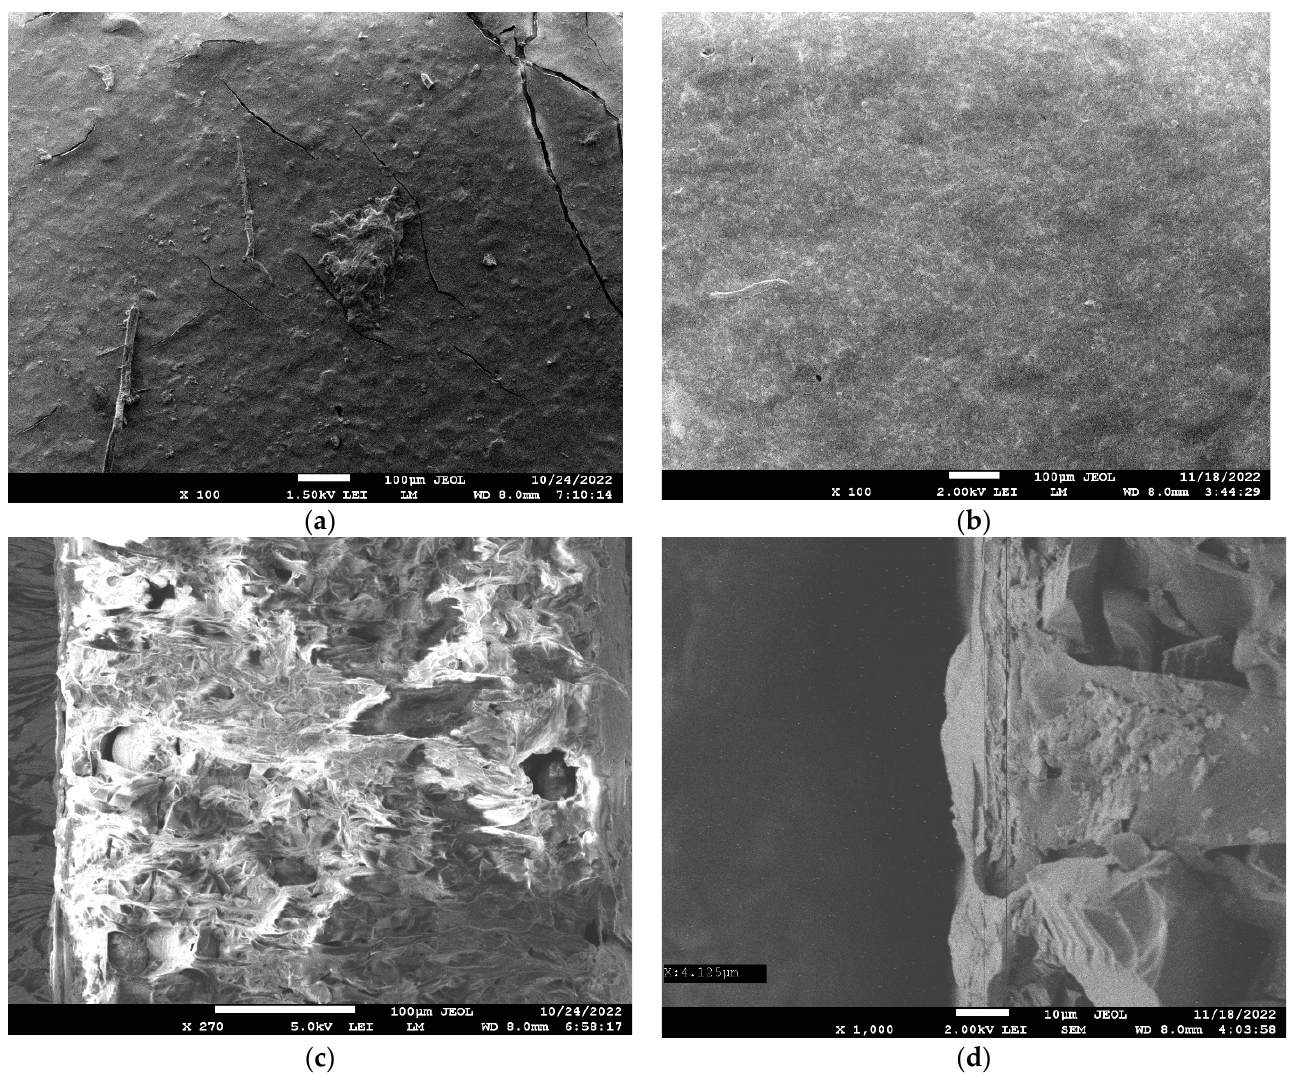
Figure 4. Top views ( a , b ) and cross sections of MK ‐ 40 ‐ M (PAH) ( a , c ) and MK ‐ 40 ‐ M (PEI) ( b , d ) membranes imaged as dry samples after their operation in electrodialysis.